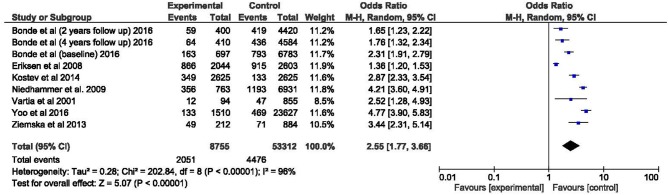
Meta-analysis of the association of workplace violence and sleep problems. Forest plot.